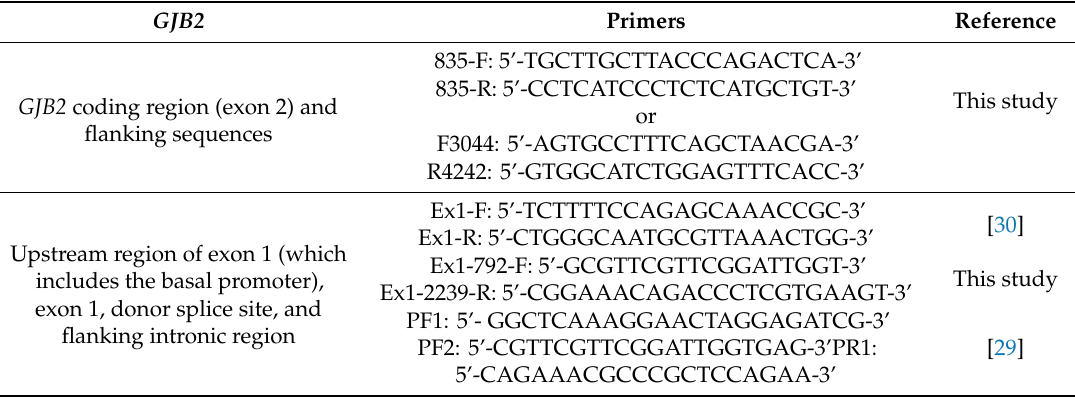
Table 1. Primers for polymerase chain reaction (PCR) / Sanger